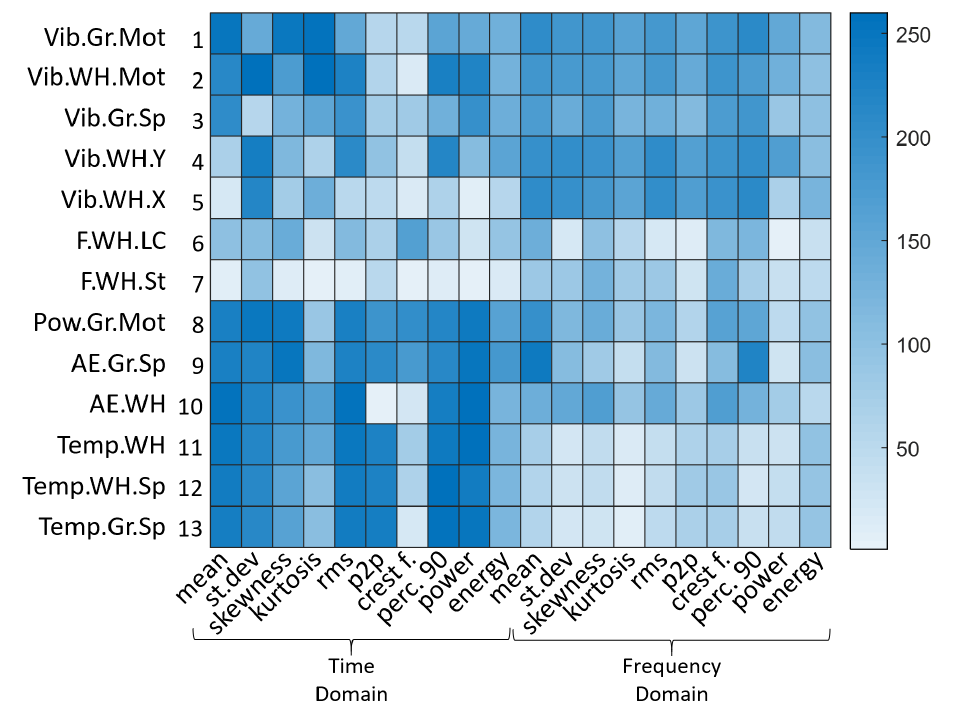
Figure 7. Heatmap of features from all segments as per NCA weights. A higher value indicates a higher feature ranking. Here Vib = Vibration, Gr = Grinding, Mot = Motor, WH = Workhead tooling, Sp = Spindle, F = Force, LC = Load Cell, St = Strain gauge, Pow = Electric Power, AE = Acoustic Emission, Temp = Temperature. Adapted from [27].